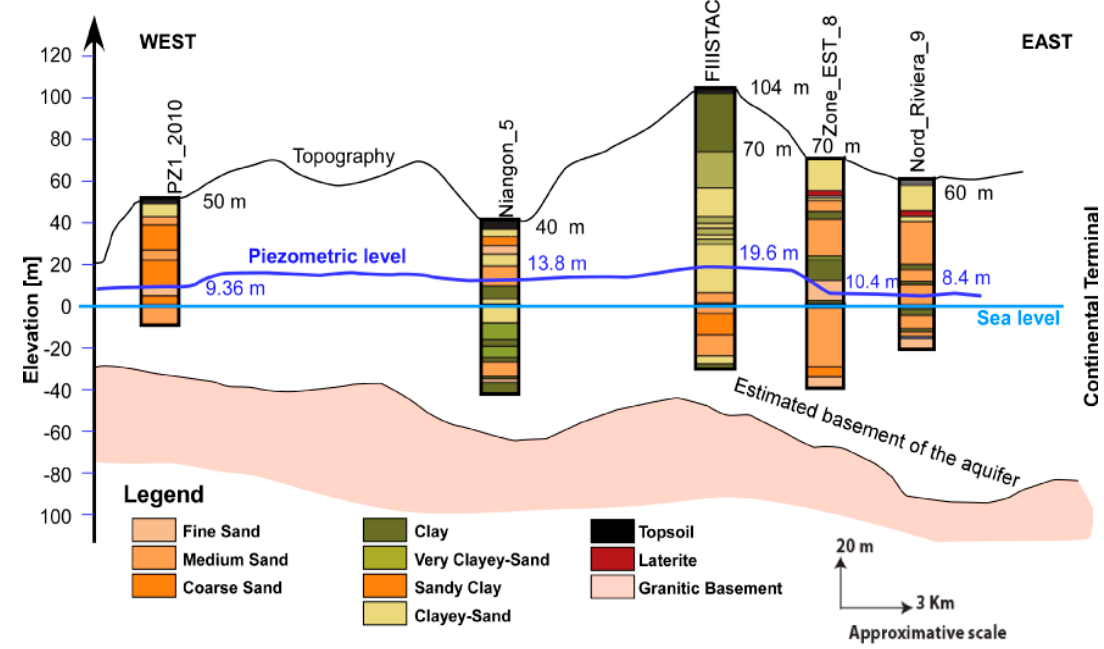
Figure 3. West–east approximate cross-section of the coastal sedimentary basin in Abidjan from boreholes on 11 December 1992.